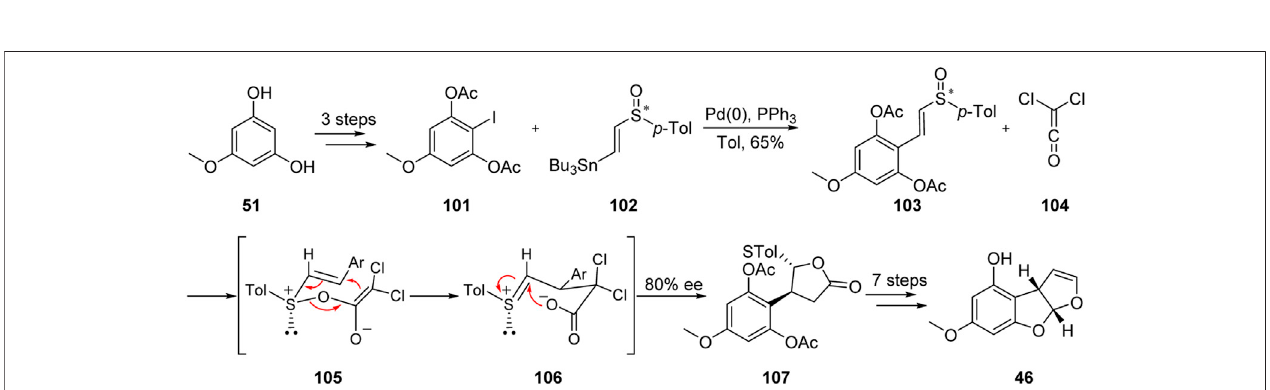
FIGURE 12 | Stereoselective formal total synthesis of a fl atoxin B